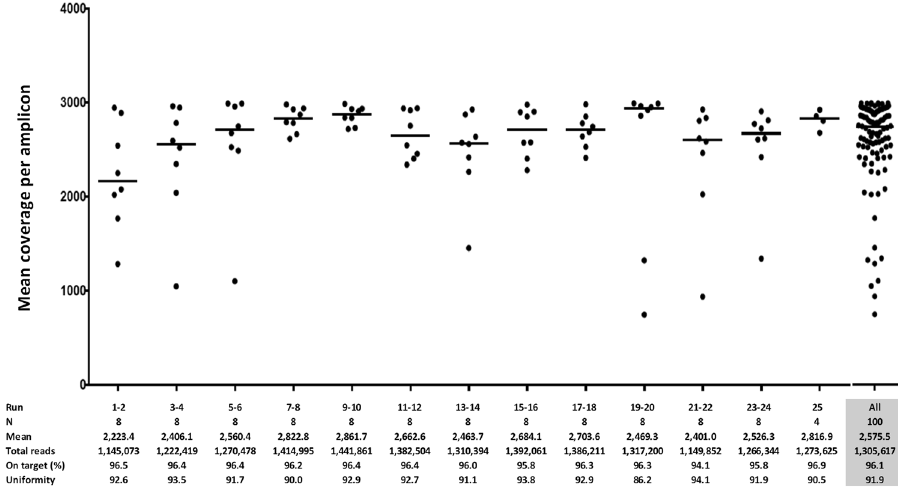
Figure 1. Quality metrics for 25 runs including mean coverage, total reads, reads on target and